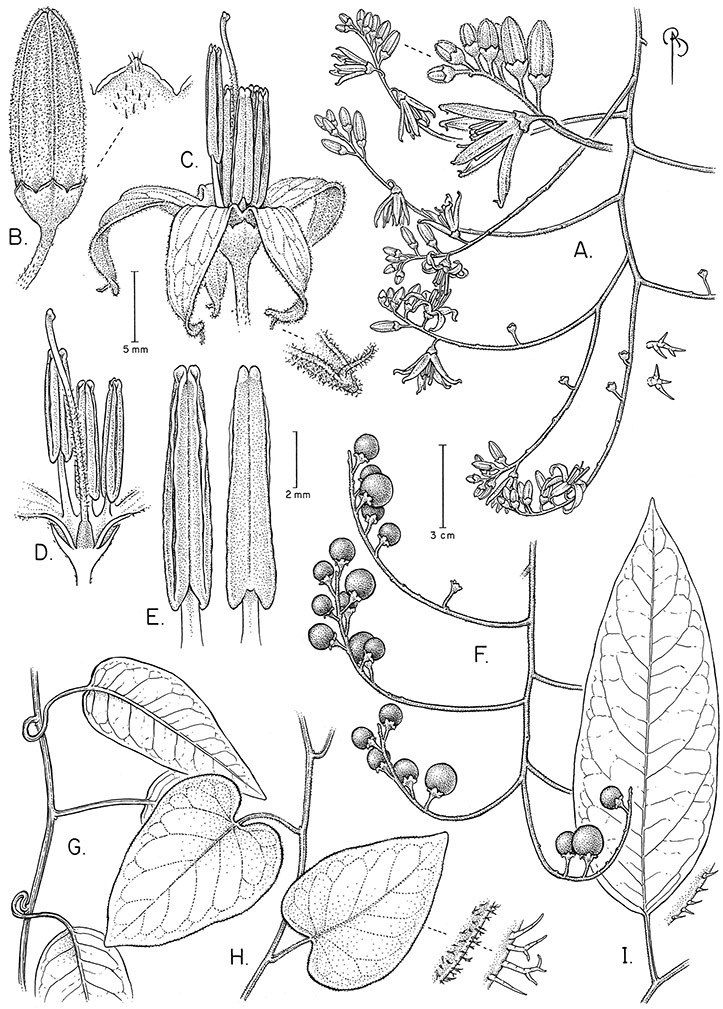
Solanum uncinellum Lindl. (A–F drawn from Hammel et al. 21289
G drawn from Nee 37364
H drawn from Nee 36071
I drawn from L.B.B. 9830). Illustration by Bobbi Angell.